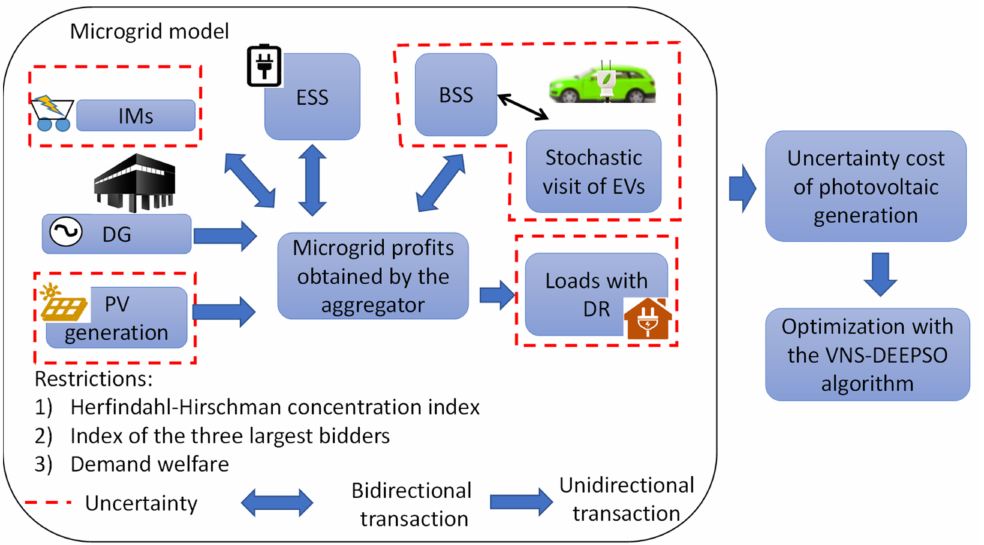
Figure 1. Structure of the electrical